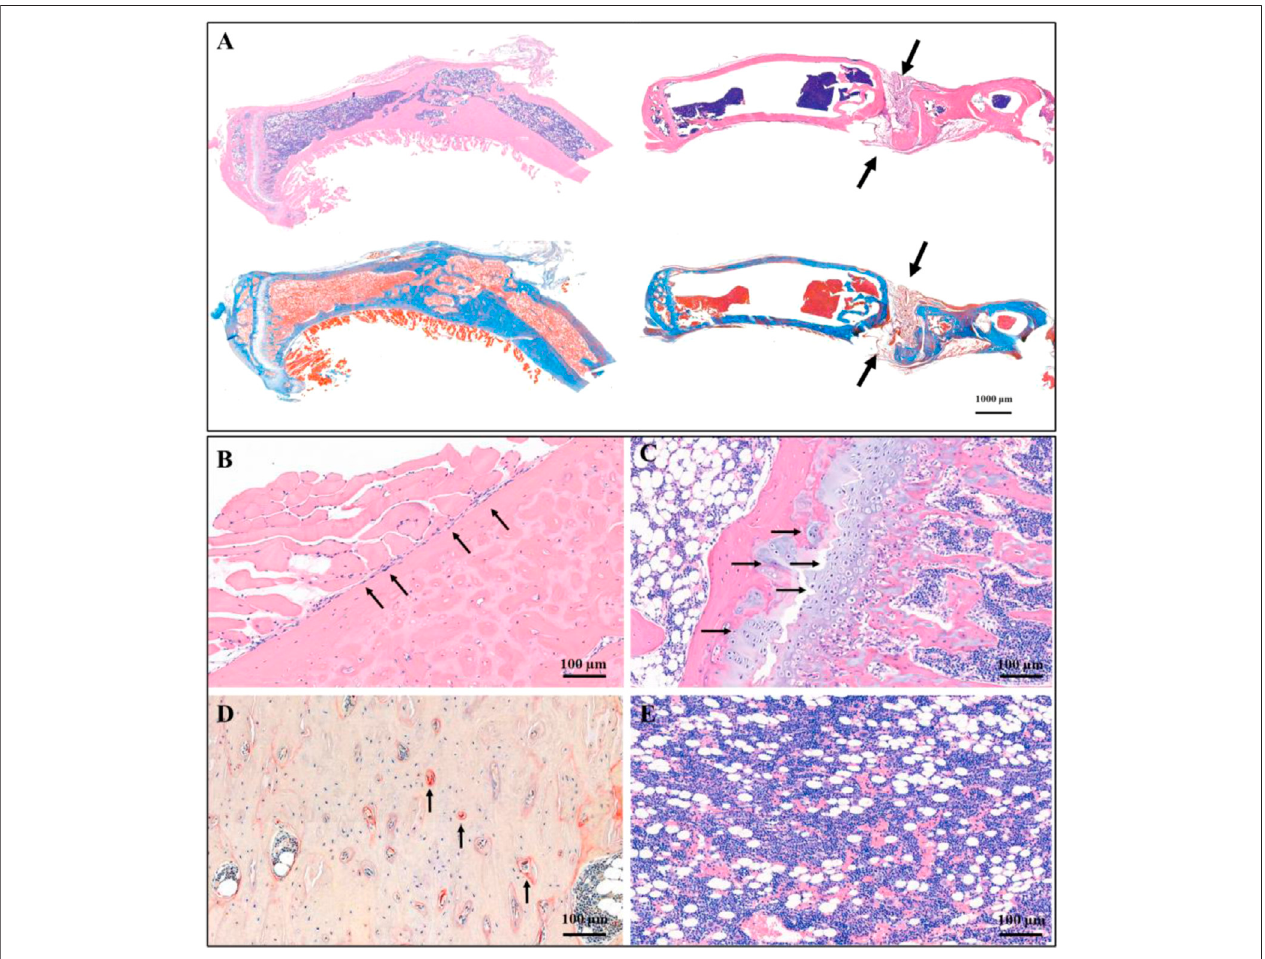
FIGURE 5 | Histological staining showed the therapeutic effect of CTC bio-composite engraftment and ZINC150338698 administration on osteosarcoma. (A) HE and Masson trichromatic staining showing the entire tibia in the experimental group (left) and the control group (right); the bone defect healed well in the experimental group, while the bone defect showed nonunion in the control group. Arrow: the unhealed bone defect; bar: 1000 μ m. (B) In the area of new bone formation, the osteoblasts lined up around the new bone tissues by HE staining, arrow: osteoblasts; bar: 100 μ m. (C) Growth of chondrocytes was detected by HE staining, indicating that the new bone is formed by endochondral ossi fi cation. Arrow: chondrocytes; bar: 100 μ m. (D) Osteoclasts were determined by tartrate-resistant acid phosphatasestaining,indicatingthedynamicbalancebetweenosteoblastsandosteoclasts.Arrow:osteoclasts;bar:100 μ m. (E) Maturebonemarrowtissueappeared in the marrow cavity. Bar: 100 μ